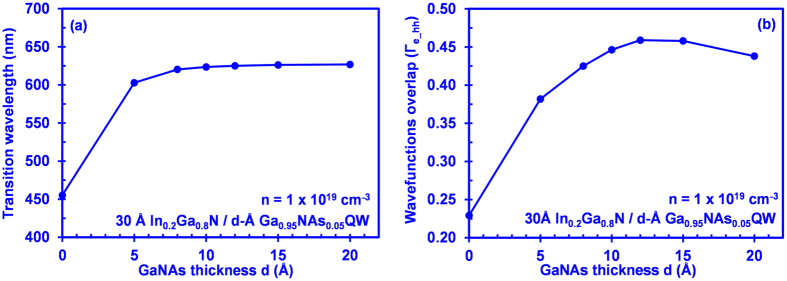
(a) Interband transition wavelength and (b) electron-hole wave function overlap as a function of GaNAs layer thickness for 30 Å In0.2Ga0.8N/d-Å GaN0.95As0.05 QW at carrier density of 1 × 1019 cm−3.